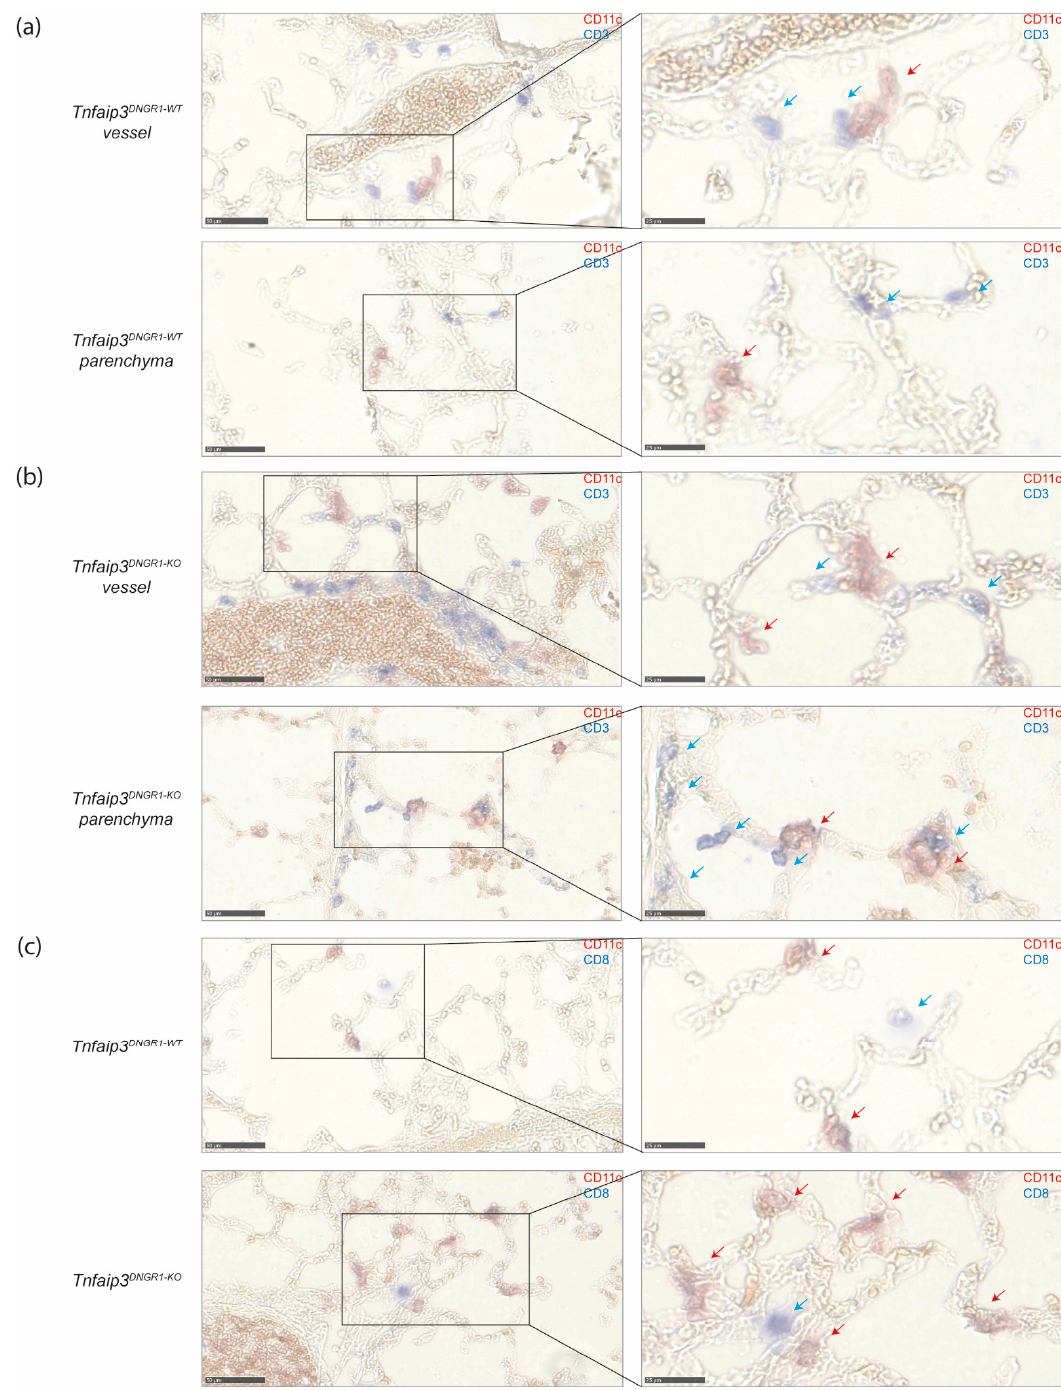
Figure 4. DCs and T cells are more often in close proximity around vessels and in parenchyma in Tnfaip3 DNGR1-KO mice. ( a ) DC (CD11c, red) and T cell (CD3, blue) staining on lung cryosections of 31-week-old WT mice of which an area around a vessel (top) and parenchyma (bottom) of the same mouse is depicted. Magnification of selected areas (right); ( b ) DC (CD11c, red) and T cell (CD3, blue) staining on lung cryosections of 31-week-old Tnfaip3 DNGR1-KO mice of which an area around a vessel (top) and parenchyma (bottom) of the same mouse is depicted. Magnification of selected areas (right); ( c ) DC (CD11c, red) and CD8+ T cells (CD8, blue) of WT (top) and Tnfaip3 DNGR1-KO (bottom) mice around a vessel. Magnification of selected area (right). Data shown are representative for 4–6 mice per group. Scale in left panels is 50 µ m and of right panels 25 µ m. Blue arrows indicate T-cells, and red arrows indicate DCs in the larger magnification (right